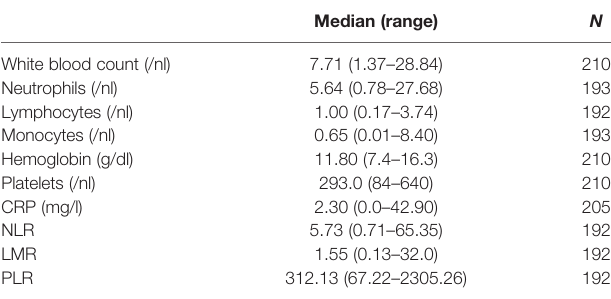
TABLE 4 | Laboratory characteristics at start of palliative therapy for r/m SCCHN.